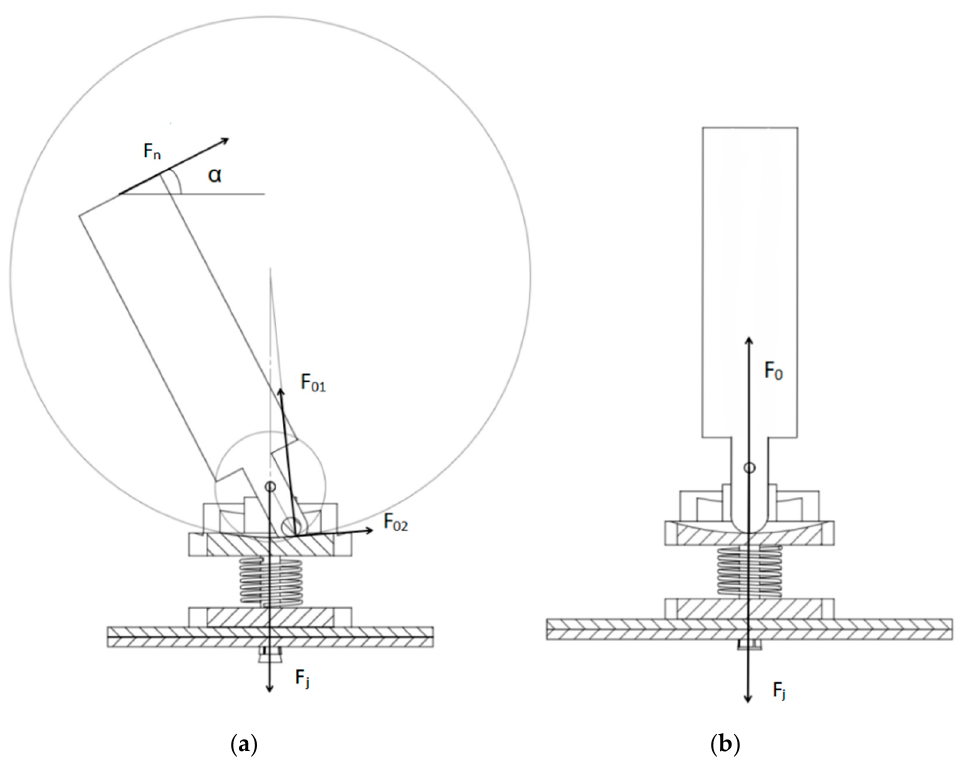
Figure 4. (a) Force analysis of the clamping process. (b) Balanced state. Assuming that the contact point between the user and the lever is at the head of the lever, the direction is perpendicular to the lever axis and diagonally upward. The reaction force of the chute table acting on the short part of the lever was decomposed into F 01 and F 02 . The direction of the F j is vertical downward, and the F j is considered to be the resultant force of the lever from the pin shaft.